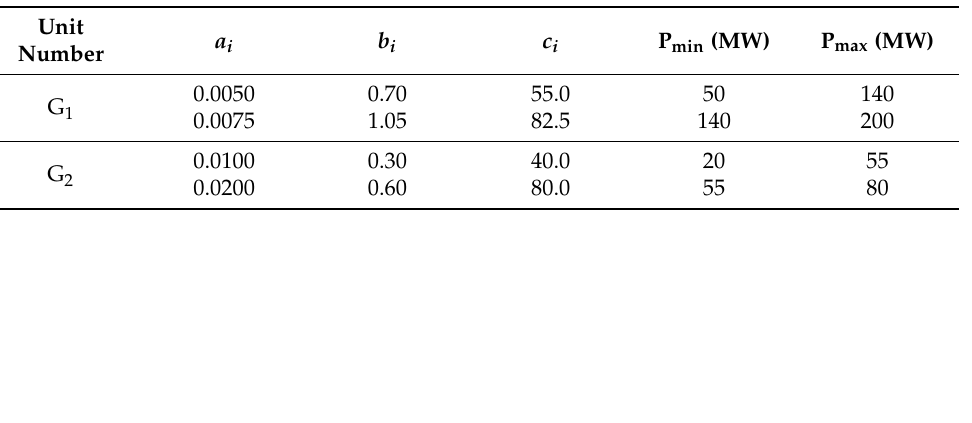
Table A2. Multi-fuel quadratic cost coefficients and output power boundary of